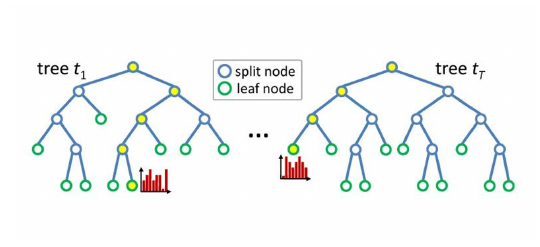
Figure 2: Decision forest . A forest consists of T decision trees. A feature vector is classified by descending each tree. This gives, for each tree, a path from root to leaf, and a class distribution at the leaf. As an illustration, we highlight the root to leaf paths (yellow) and class distributions (red) for one input feature vector. (Figure courtesy by Jamie Shotton (Shotton et al., 2008).)